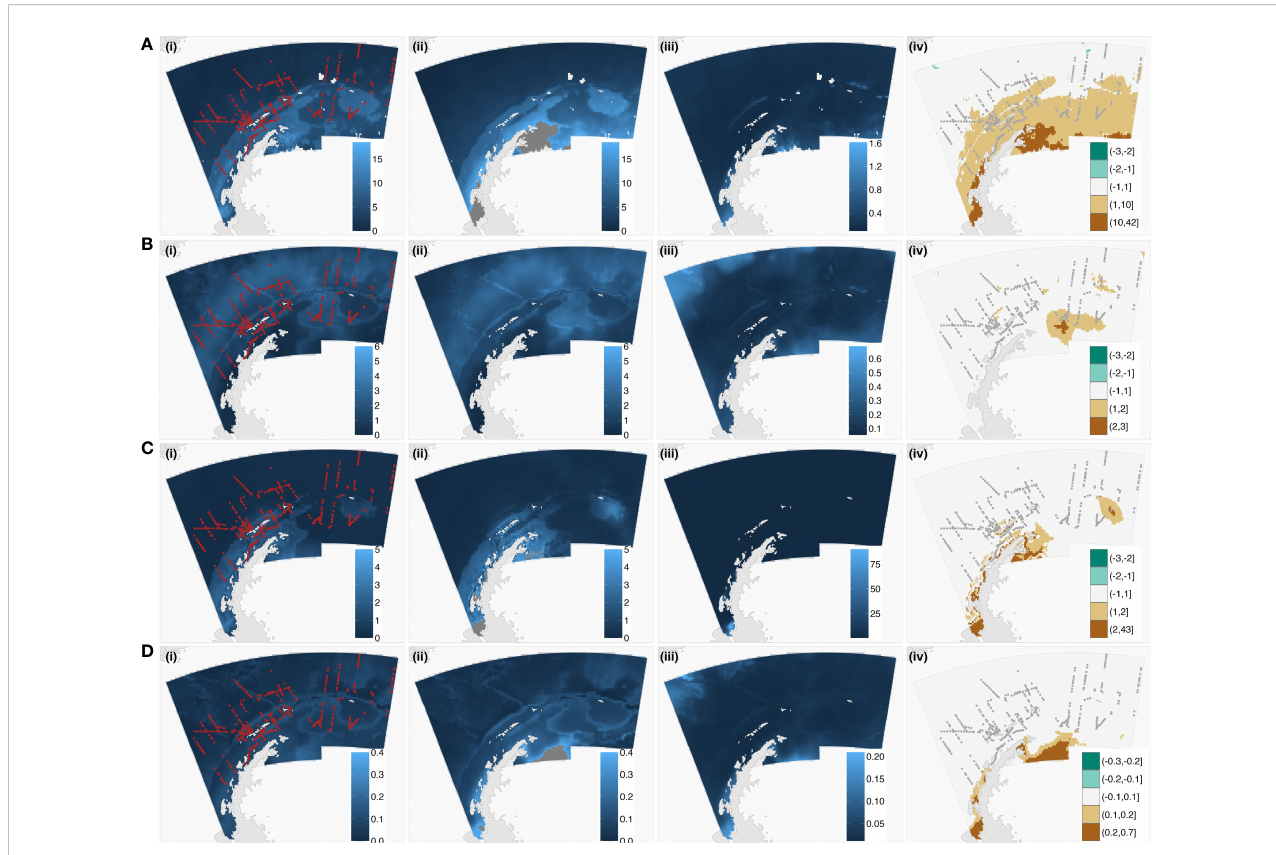
FIGURE 3 Scienti fi c vessel-based sampling of the humpback (A) , fi n (B) , minke (C) , and blue (D) simulated whale fi elds. Plotted left to right are; (i) the simulated whale fi eld (lighter blues are the higher density of whales) and scienti fi c vessel-based sampling (red lines), (ii) the equivalent modeled whale densities on the same color scale (noting dark grey regions are those where predictions are far greater than the original simulated whale fi eld, see Table 4 for the value ranges), (iii) grid-scale coef fi cient variations (CV) and, (iv) the true spatiality explicit differences between simulated (i) and modeled (ii) whale fi elds (scale from greens (underestimate) to white (approximately equal) to browns (overestimated)) with science vessel-based sampling (grey lines). These plots show the model generally predicted the spatial patterns in the original simulated whale fi elds well but performed poorly in some regions (iv). Compare grid-scale CV (iii) with true differences (iv) for inconsistencies between model output and the actual differences between the simulated and modeled grid-scale whale densities.